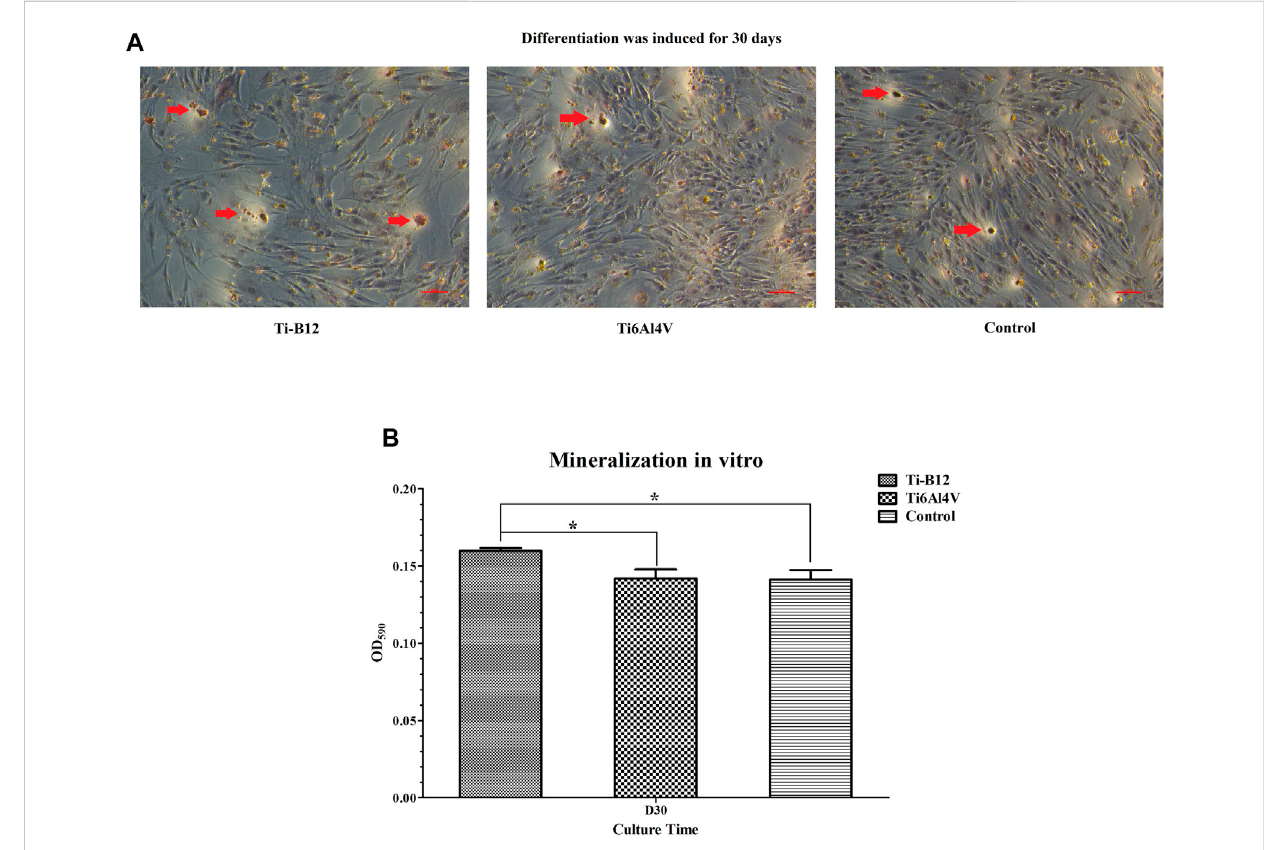
FIGURE 9 Osteoblast mineralization. (A) calcium salts in mineralized nodules were stained dark red by alizarin red staining, shown by the red arrow. (B) quantitative determination of calcium salt deposition.